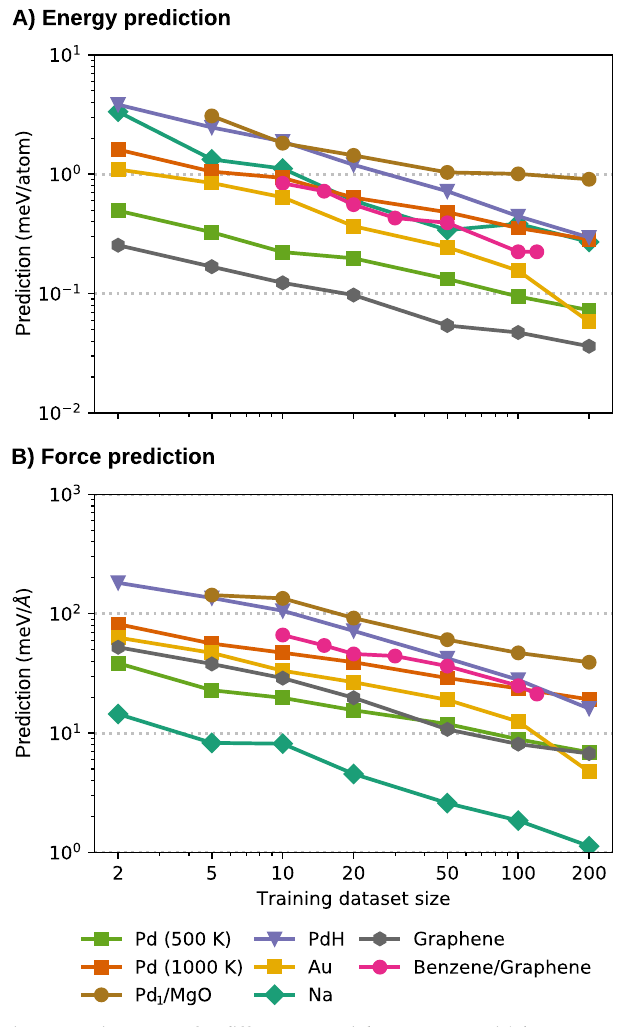
Fig. 2 Learning curves for different materials. A Energy and ( B ) Forces. 3D bulk materials: Pd(FCC), Na(BCC), and Au(FCC). 2D material: Graphene. Interstitial in materials: H in a supercell of Pd. Chemisorption of atom at a surface: Single Pd atom adsorbed on a MgO (100) surface. Van der Waals interactions: Benzene molecule adsorbed on graphene. Their respective full ( fl uxional) symmetry group, supercell dimensions and reference levels of theory used in each case are presented in Methods section. The reported values are the mean absolute errors (MAE). See Supplementary Fig. 1 for additional information on the learning